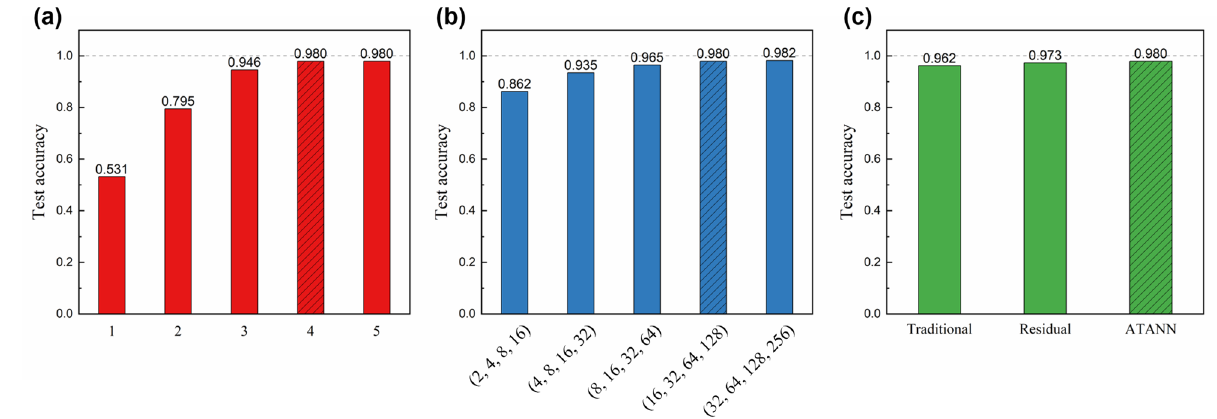
Figure 5. Comparison of the recognition performance for model architectures. Influence of ( a ) the number of convolution blocks and ( b ) the number of filters in convolutional layers. Recognition performance for models with different configurations of convolution blocks. All data presented here are the result for a data set 2 1 × 10 − 14 m − 2 / 3 and (cid:31) l = 0.15 ) and represent the mean values of 5 test results. Hatched bars in each bar ( C n = graph represent results of the proposed ATANN.